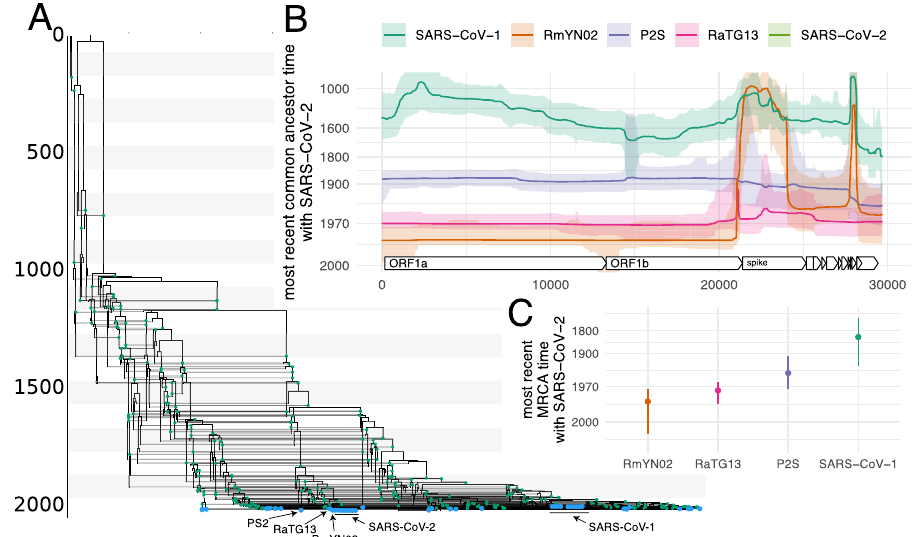
Fig. 1 Evolutionary history of SARS-like viruses. A Maximum clade credibility network of SARS-like viruses. Blue dots denote samples and green dots recombination events. B Common ancestor times of Wuhan-Hu1 (SARS-CoV-2) with different SARS-like viruses on different positions of the genome. The y -axis denotes common ancestor times on the log scale. The line denotes the median common ancestor time, while the colored area denotes the 95% highest posterior density interval. C Most recent time anywhere on the genome that Wuhan-Hu1 shared a common ancestor with different SARS-like viruses. The error bars denote the upper and lower bound of the 95% highest posterior density interval. The MCC network and common ancestor times are provided as a Source Data fi